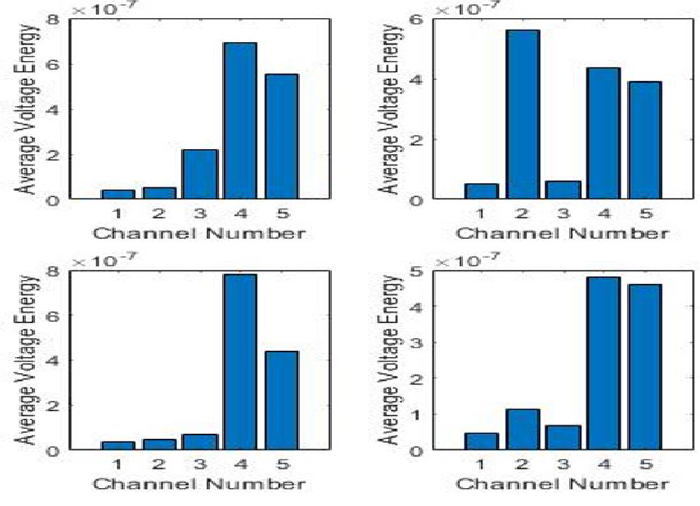
Figure 9. Average energy for sensors 1 to 5.